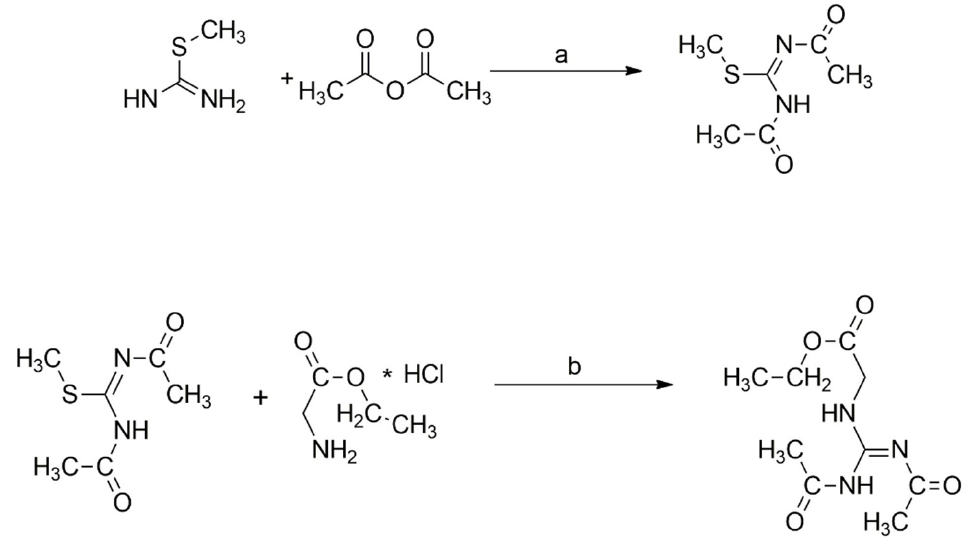
Figure 3. Synthesis of Diacetyl-GAAE. Reagents and conditions: ( a ) TEA, DCM, RT, 2 h; ( b ) TEA, HgCl2, THF, RT, 24 h. See text for more details.